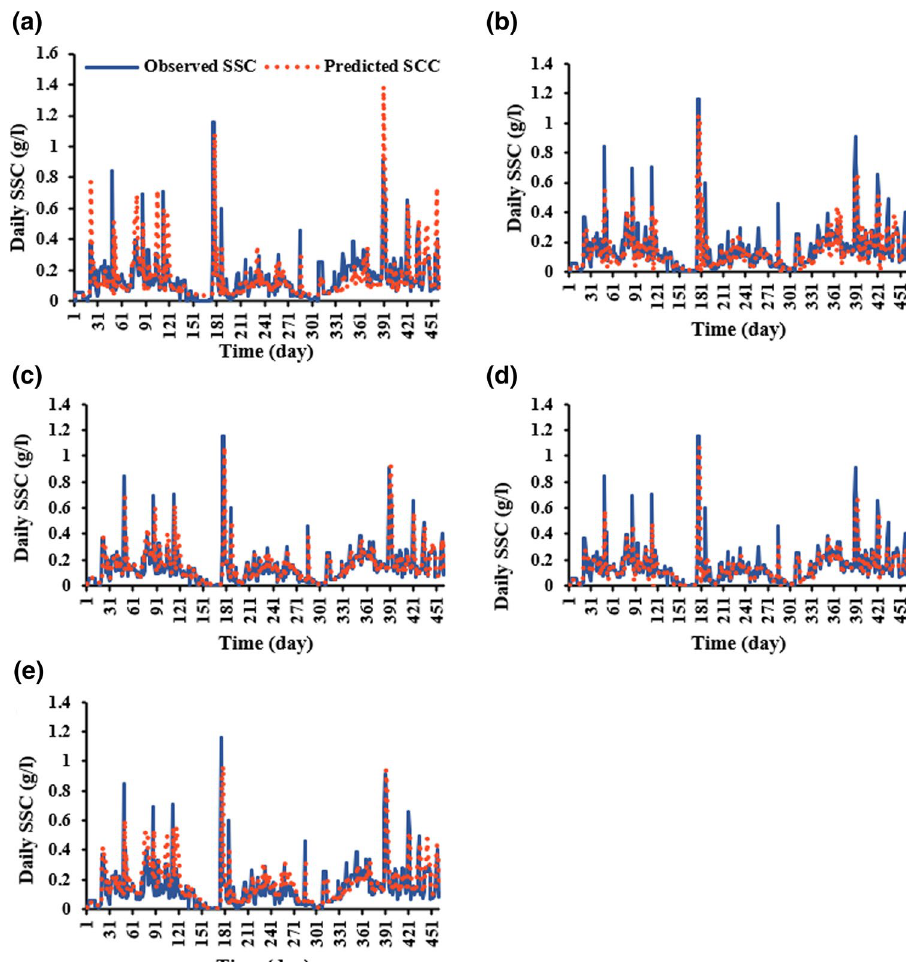
Fig. 10 Line diagram of devel- oped models a ANN, b WANN, c SVM, d WSVM and e MLR during the testing phase for Ghatshila